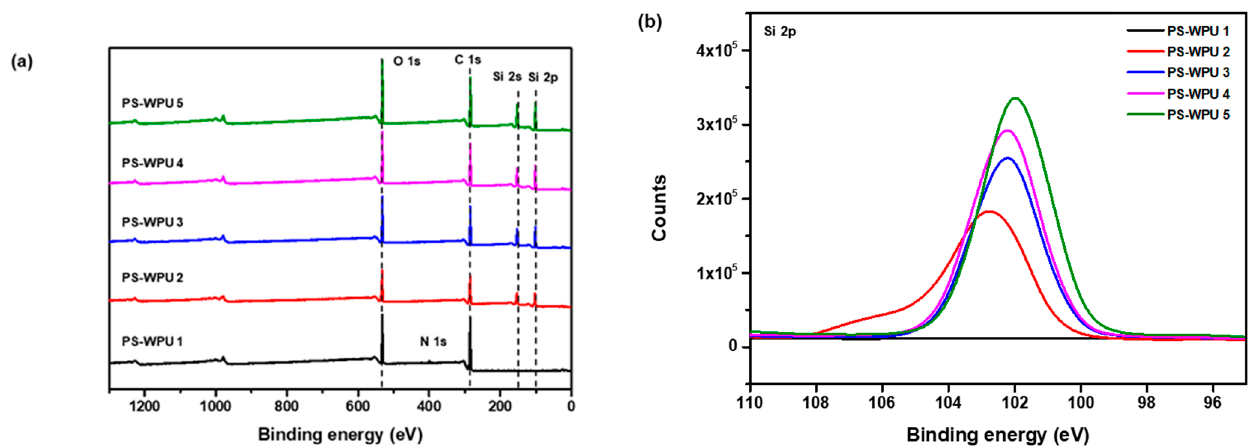
Figure 3. X-ray diffraction patterns of PS-WPU samples.